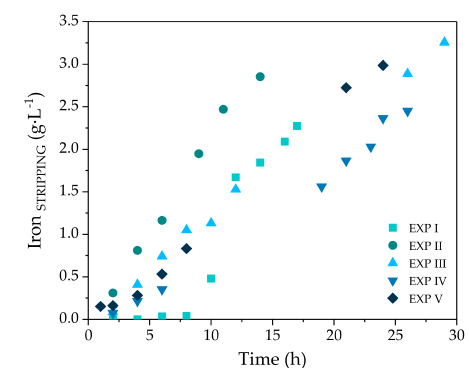
Figure 4. Iron concentration with experimental time in the stripping (S) phase using NDSX technology for EXP I–V.